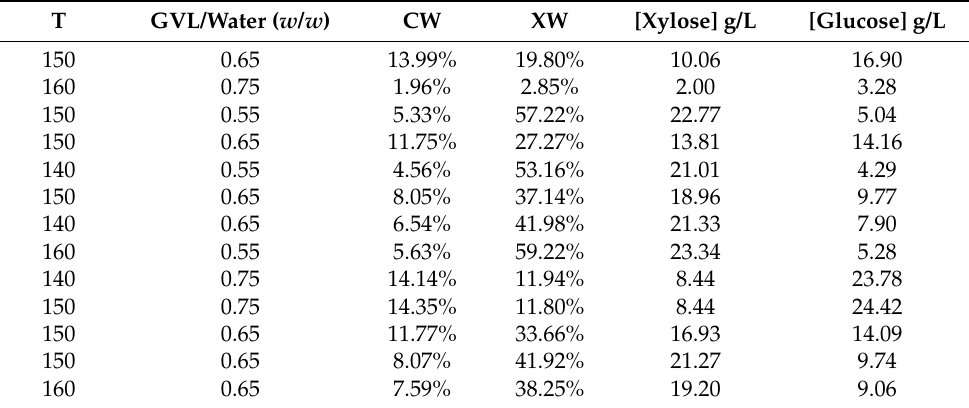
Table 3. Xylan-derived xylose and cellulose-derived glucose concentrations in the aqueous fraction. CW and XW are the mass of cellulose and xylan, respectively, recovered in the aqueous fraction respective to their initial contents in the